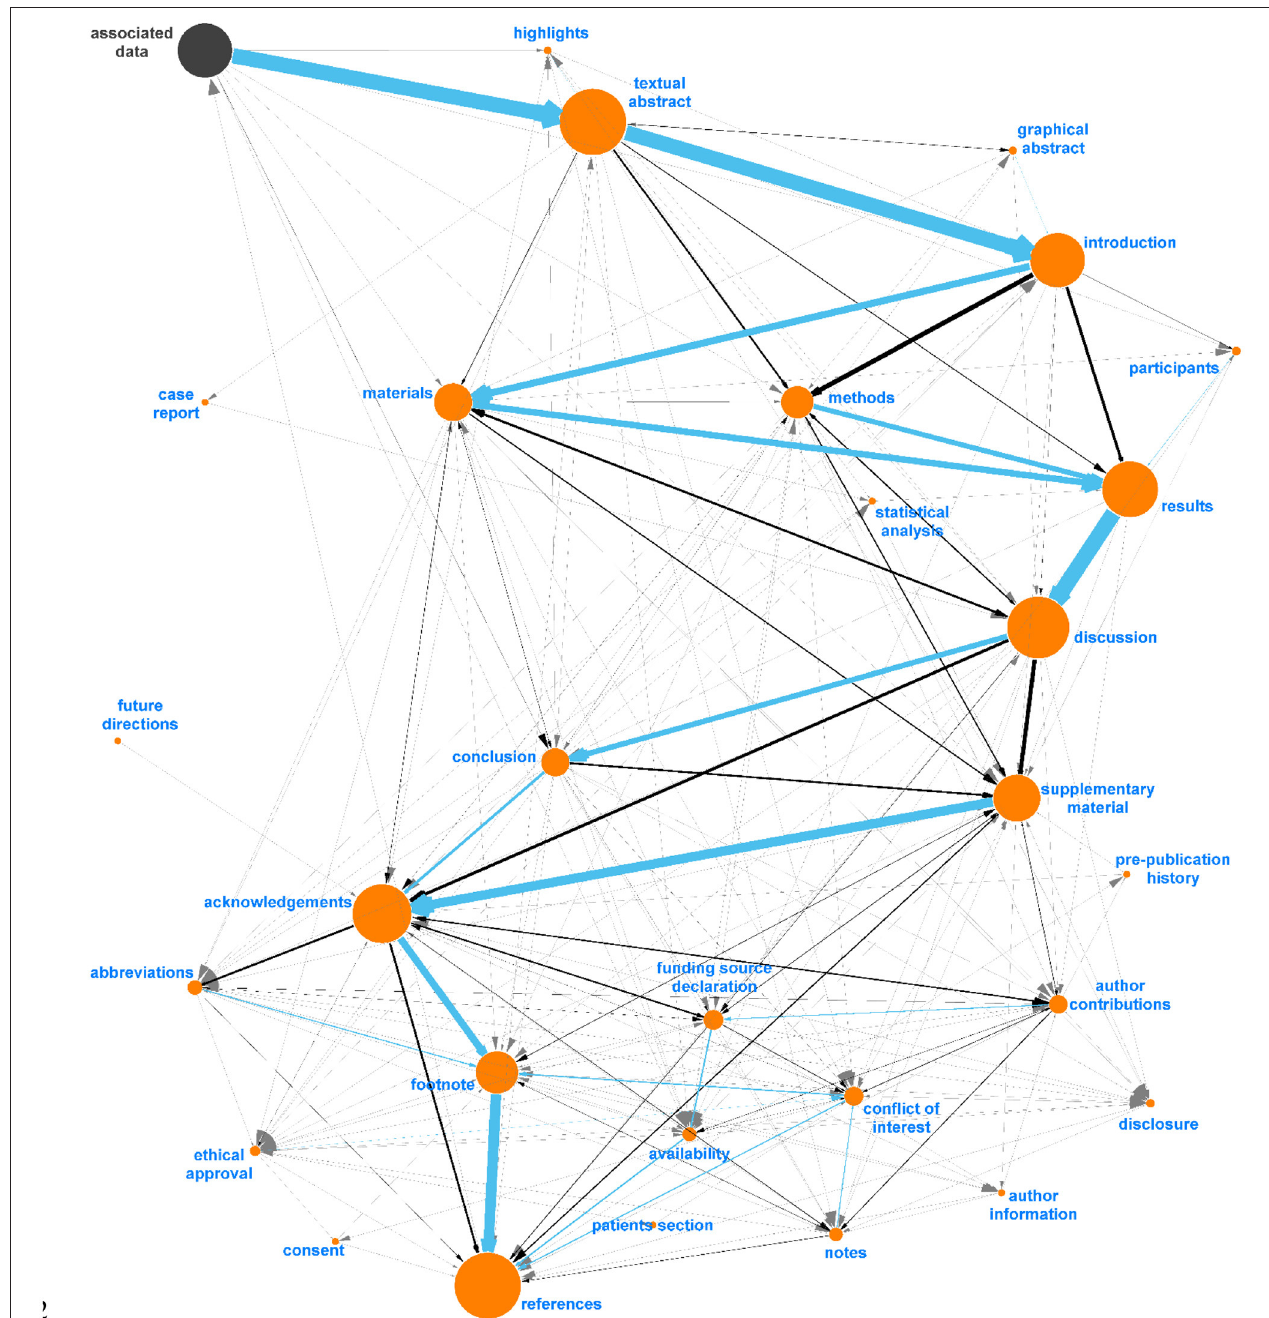
FIGURE 5 | Final digraph model used in Auto-CORPus to classify paragraphs after fuzzy matching to IAO terms (v2020-06-10). This model includes new (proposed) section terms and each section contains new synonyms identified in this analysis. “Associated Data” is included as this is a PMC-specific header found before abstracts and can be used to indicate the start of most articles, all IAO terms are indicated in